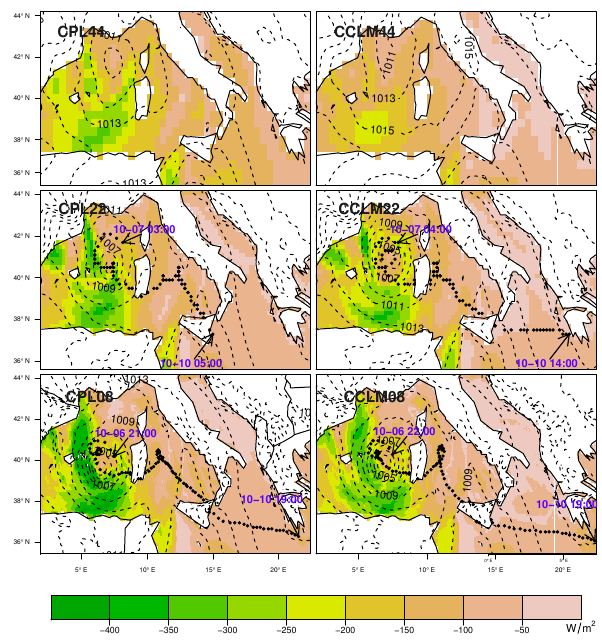
Figure 6. ME08; mean sea level pressure (hPa; dotted contours lines at 2hPa intervals) and latent heat flux (Wm 2 ; colored contours at 50Wm 2 intervals) in the coupled and atmosphere-only (0.44, 0.22, and 0 . 08 ◦ ) simulations on 7 October 1996 at 18:00UTC. Black dots represent track of the